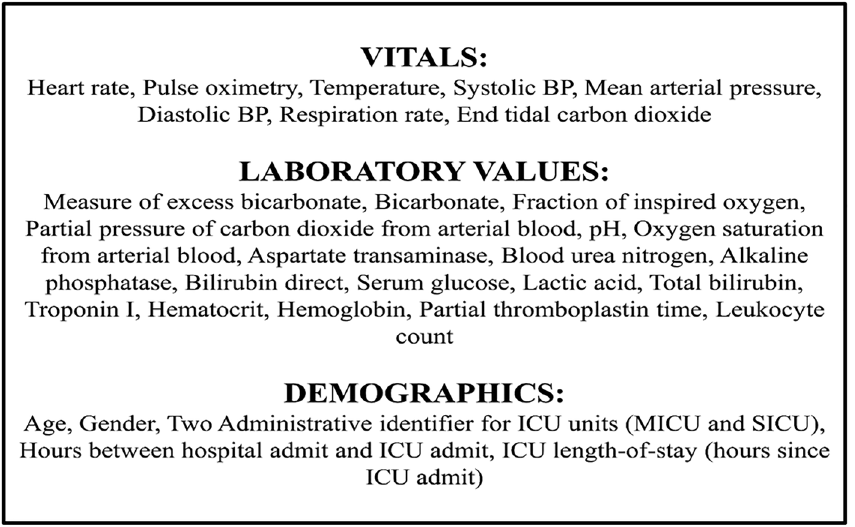
Figure 3. The complete list of sepsis features available for sepsis diagnosis from the 2019 PhysioNet Challenge; more details can be found in Ref. 5